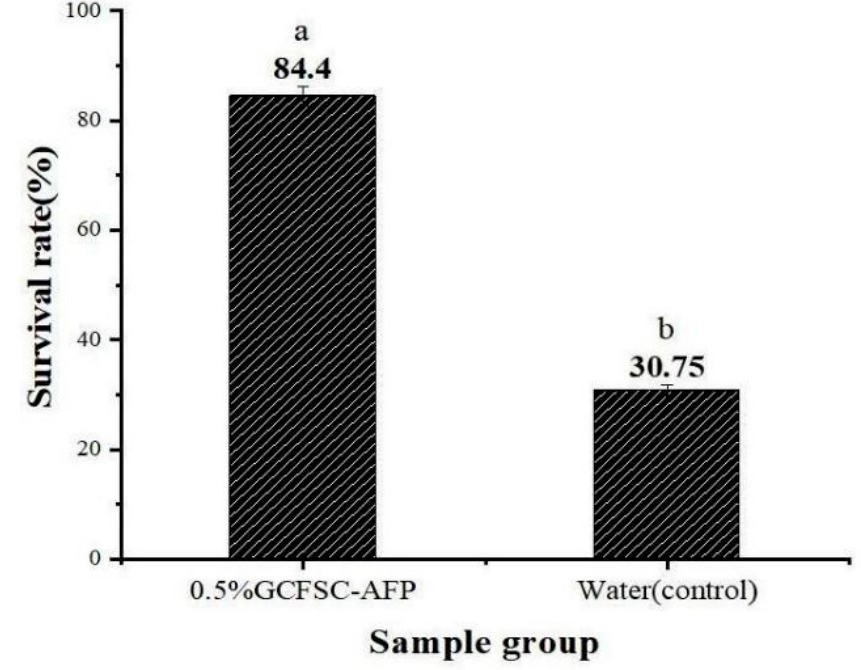
Figure 6. The hypothermia protective effect of 0.5% GCFSC-AFPs on yeast following 1-w of freezing at − 20 °C. Data were expressed as the mean ± SD. Note: Means with the same letter in the same column showed no significant difference ( p ≥ 0.05).